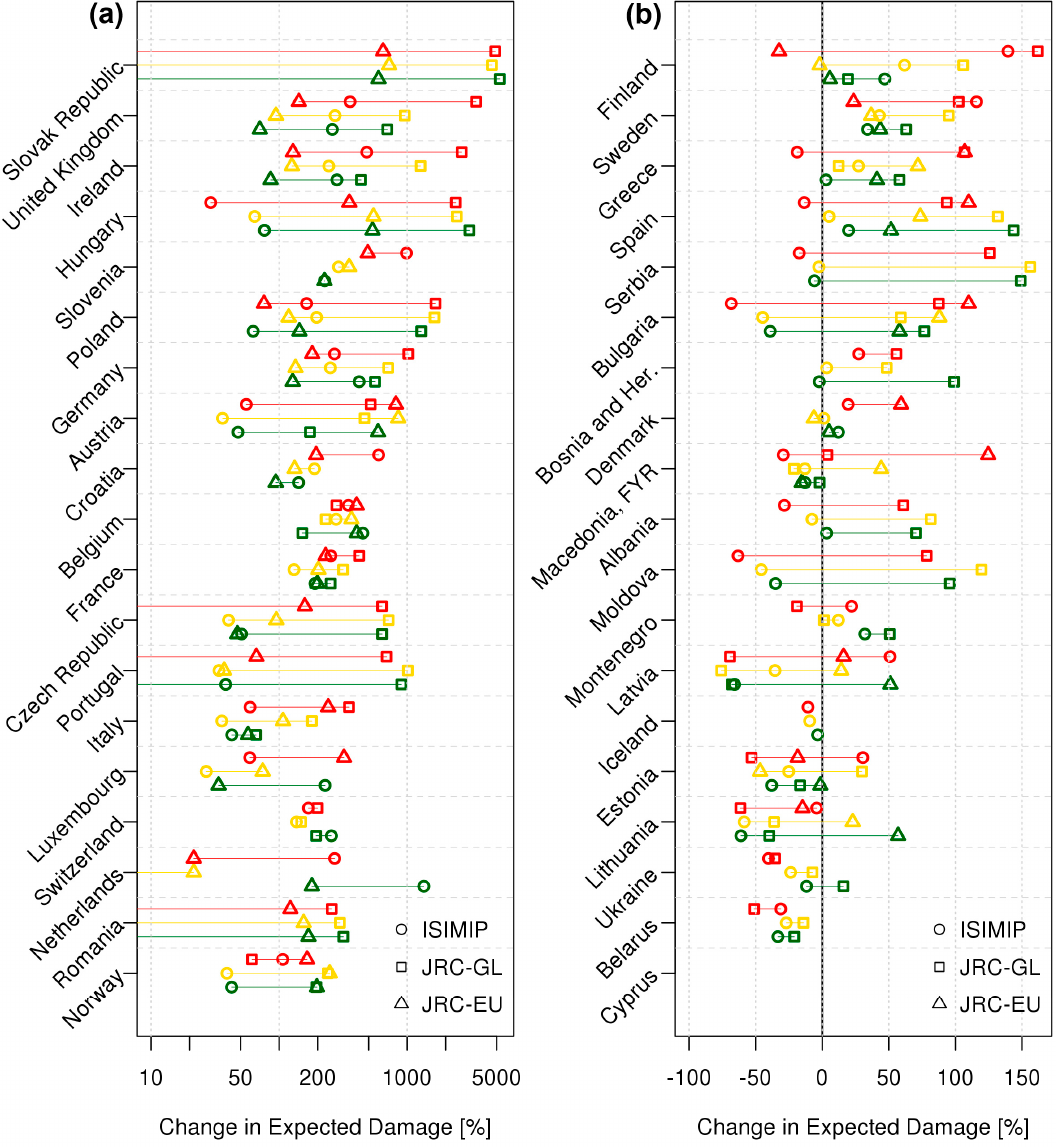
Figure 5. Relative average change in expected damage for 1.5 °C (green), 2 °C (yellow), and 3 °C (red) warming scenarios with respect to the baseline, calculated at country level for the three ensembles ( a , b ). Note that the x-axis in ( a ) uses a logarithmic scale.